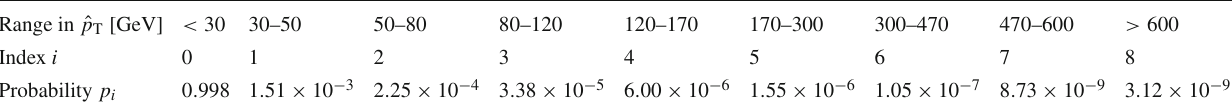
Table 6 Probabilities p i for a single inelastic pp scattering interaction to feature a transverse momentum exchange between the protons that is within the i th interval in ˆ p T Range in ˆ p T [GeV] < 30